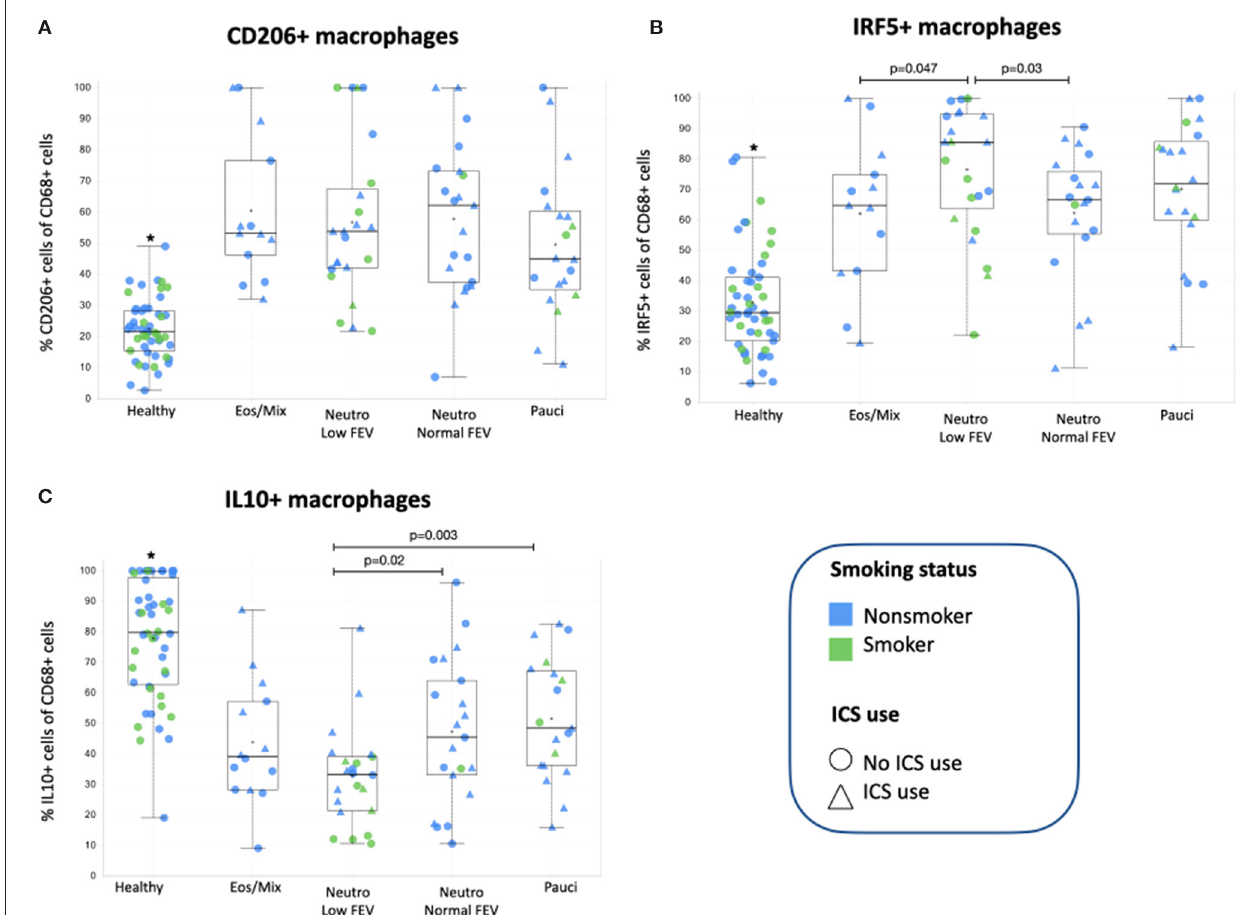
FIGURE 2 | (A) The percentage of CD206 + macrophages present in bronchial biopsies of patients from the four subclusters and healthy controls. (B) The percentage of IRF5 + macrophages present in bronchial biopsies of patients from the four subclusters. (C) The percentage of IL10 + macrophages present in bronchial biopsies of patients from the four subclusters and healthy controls. *Healthy controls were added for comparison and are significantly different ( p = 1.9E-17 for IRF5 + , p = 3.9E-17 for CD206 + , and p = 3.1E-15 for IL10 + macrophages respectively) from individuals with asthma as we have reported before (6). The asthma subgroups were compared using one-way ANOVA with post-hoc testing to compare groups, p -values < 0.05 were considered significant. ICS, inhaled corticosteroids.